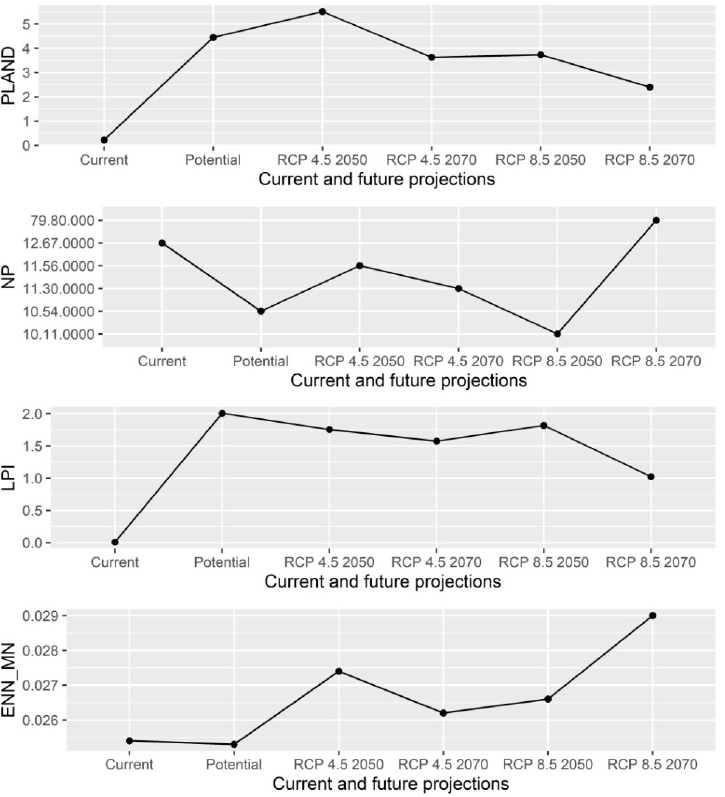
Figure A1. Landscape metrics (PLAND, NP, LPI, and ENN_MN) results for current and future projections. Table A1. Transition matrices showing the proportion of the landscape, in percentage that undergoes change for each of the potential combinations of MSPA categories for current and future projections.